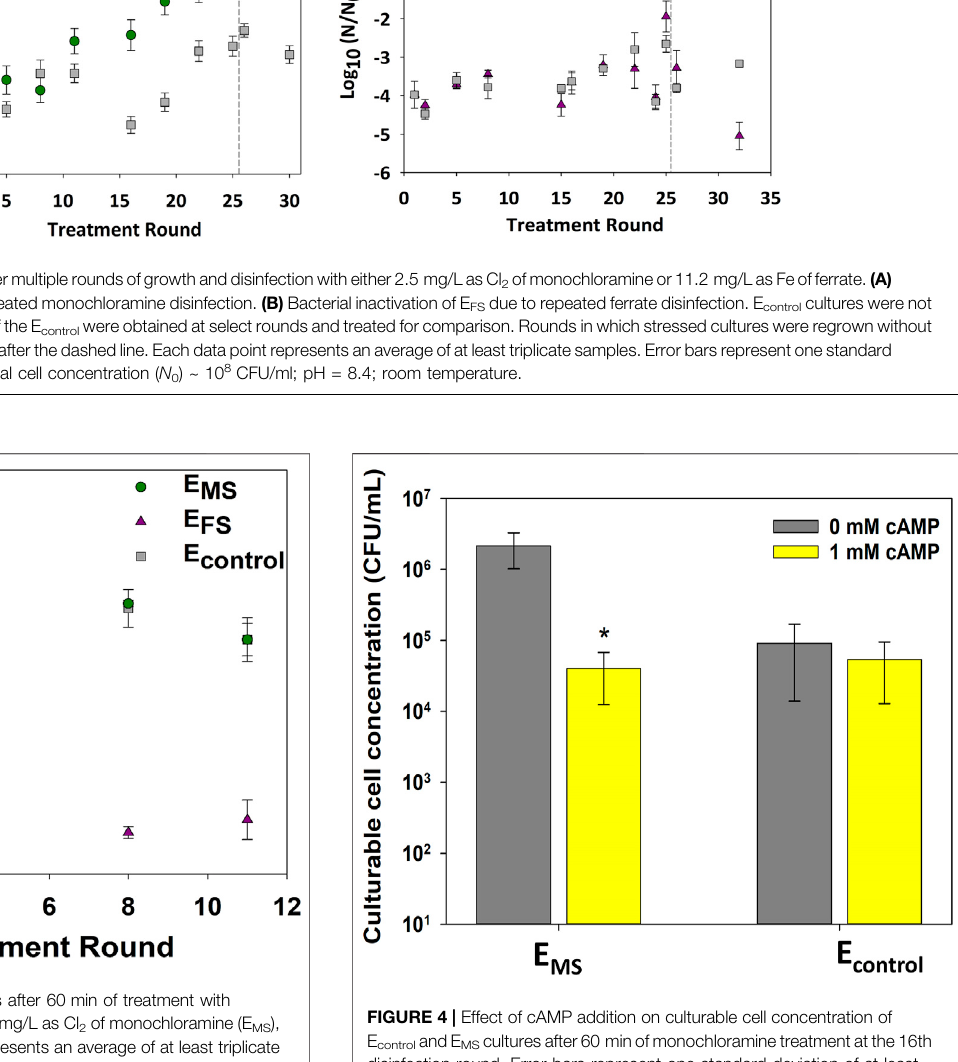
Frontiers in Environmental Science |